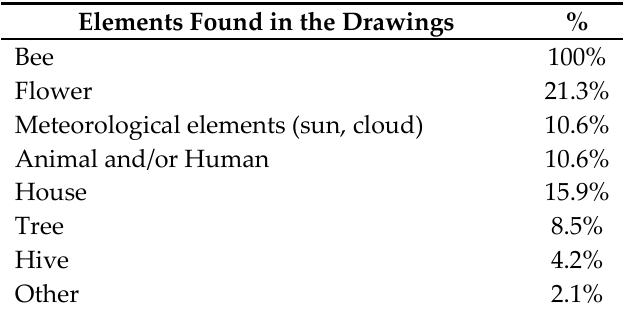
Table 2. Elements found in the drawings.